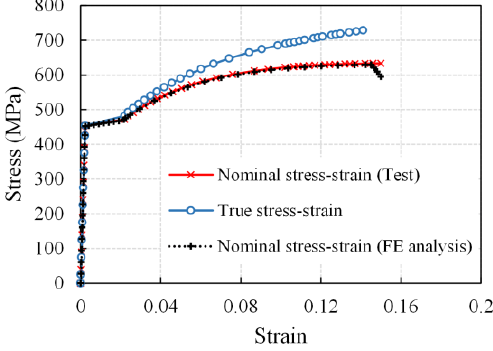
Figure 12. Stress – strain relation of uncorroded steel bar. Figure 12. Stress–strain relation of uncorroded steel